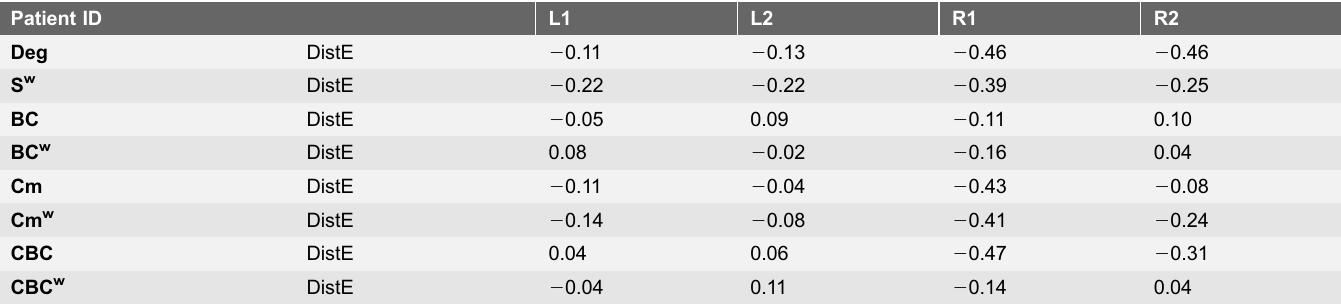
Table 5. Correlation coefficients of local differences from the control group with the Euclidean distance from the lesion are reported for each stroke patient and each network metric. Patient